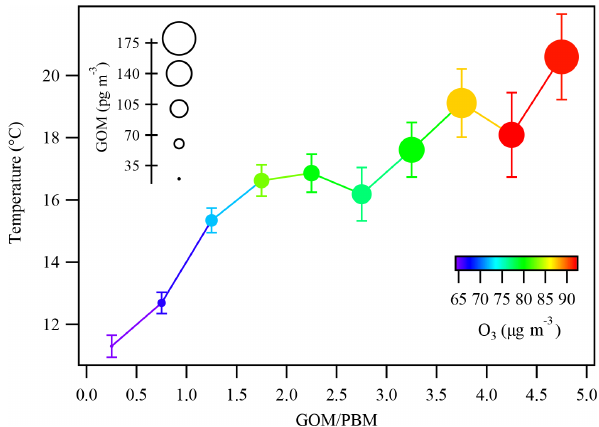
Figure 12. Temperature variations in each bin of the GOM / PBM ratios. The dots are colored by the concentrations of O 3 and the sizes of the dots represent the concentrations of GOM. The bars represent 1 standard error of temperature in each bin.